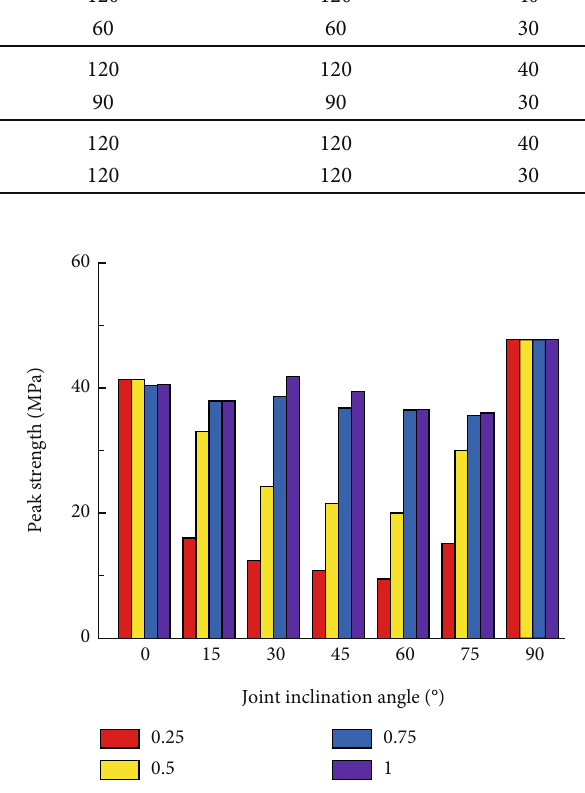
Figure 10: The change of peak strength with di ff erent strength ratios between structural surface and rock mass.